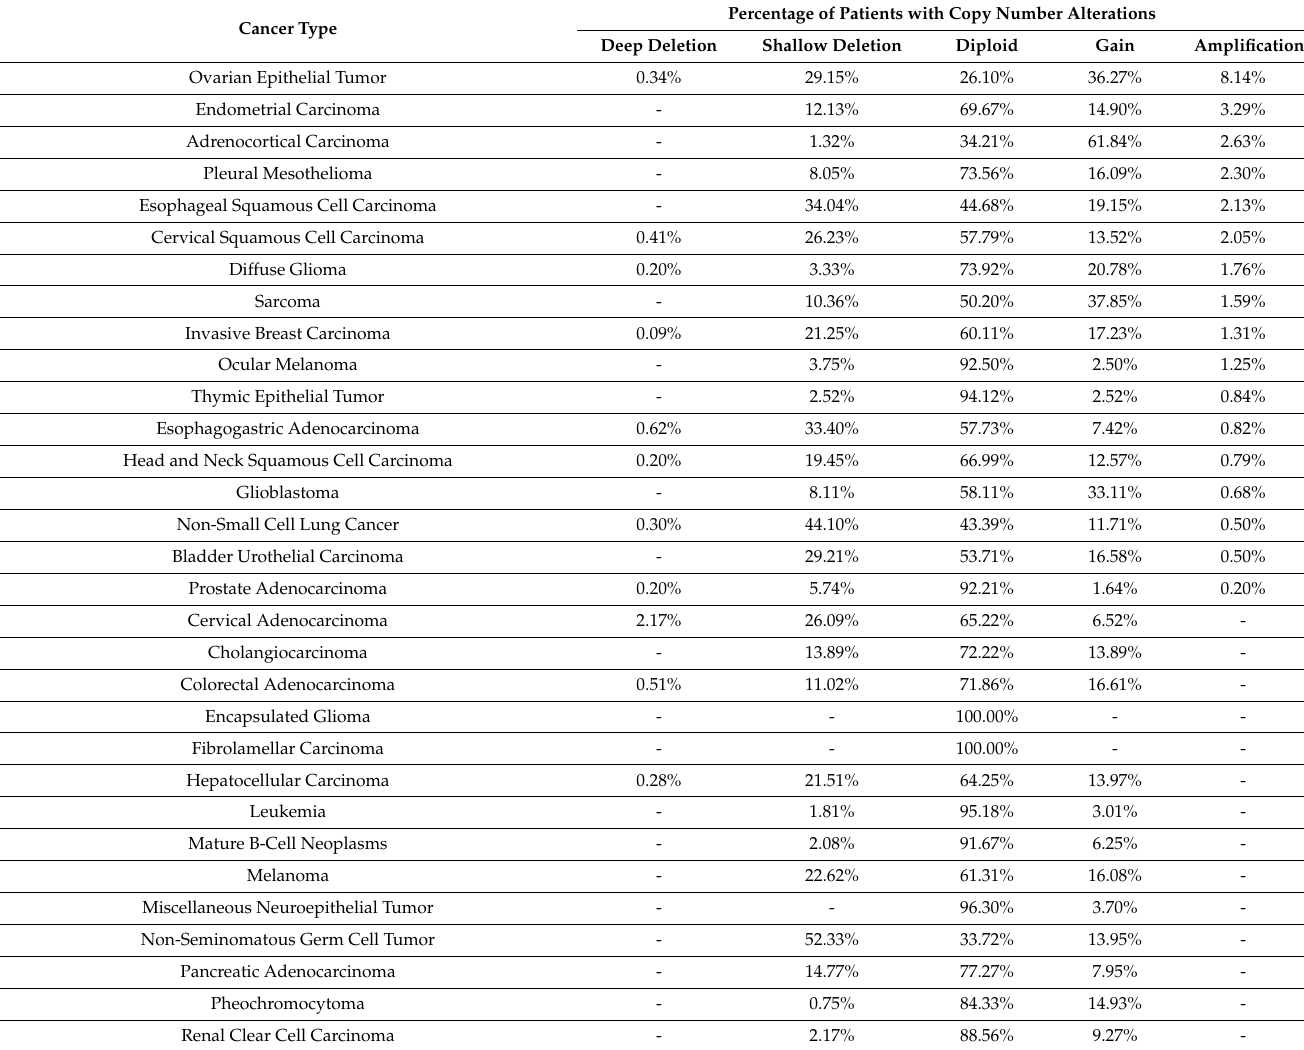
Table 3. Percentage of patients with RNASEH2A copy number alterations from Genomic Identification of Significant Targets in Cancer (GISTIC) in The Cancer Genome Atlas (TCGA) Pan Cancer